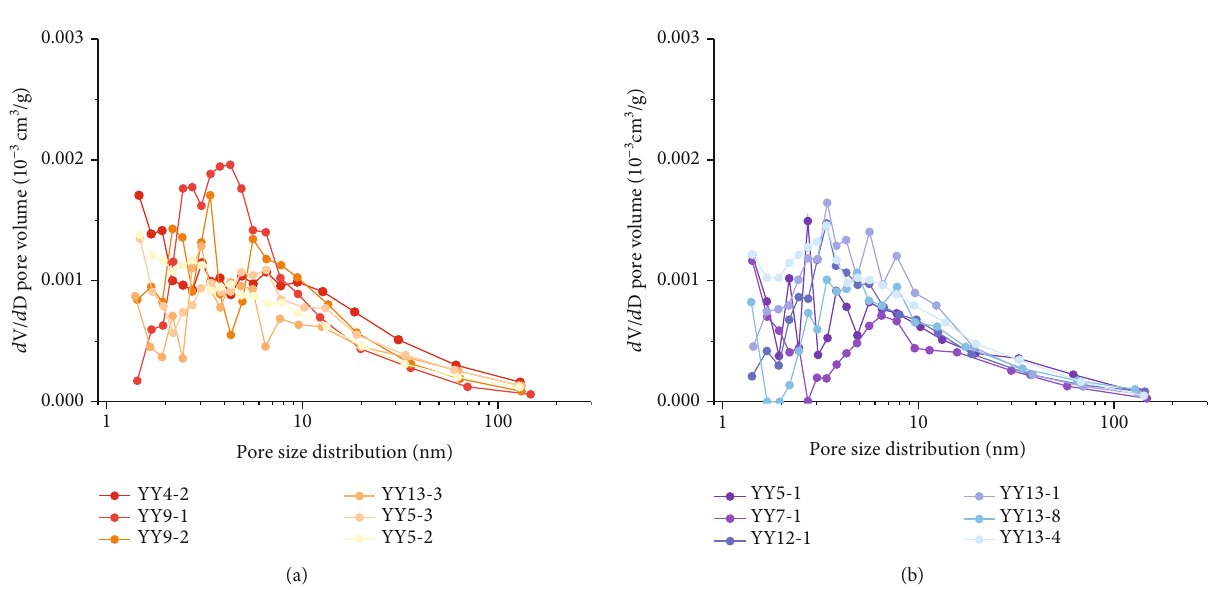
Figure 4: Pore size distribution of the Chang 7 samples obtained from nitrogen adsorption. (a) SM lithofacies. (b) MS lithofacies.